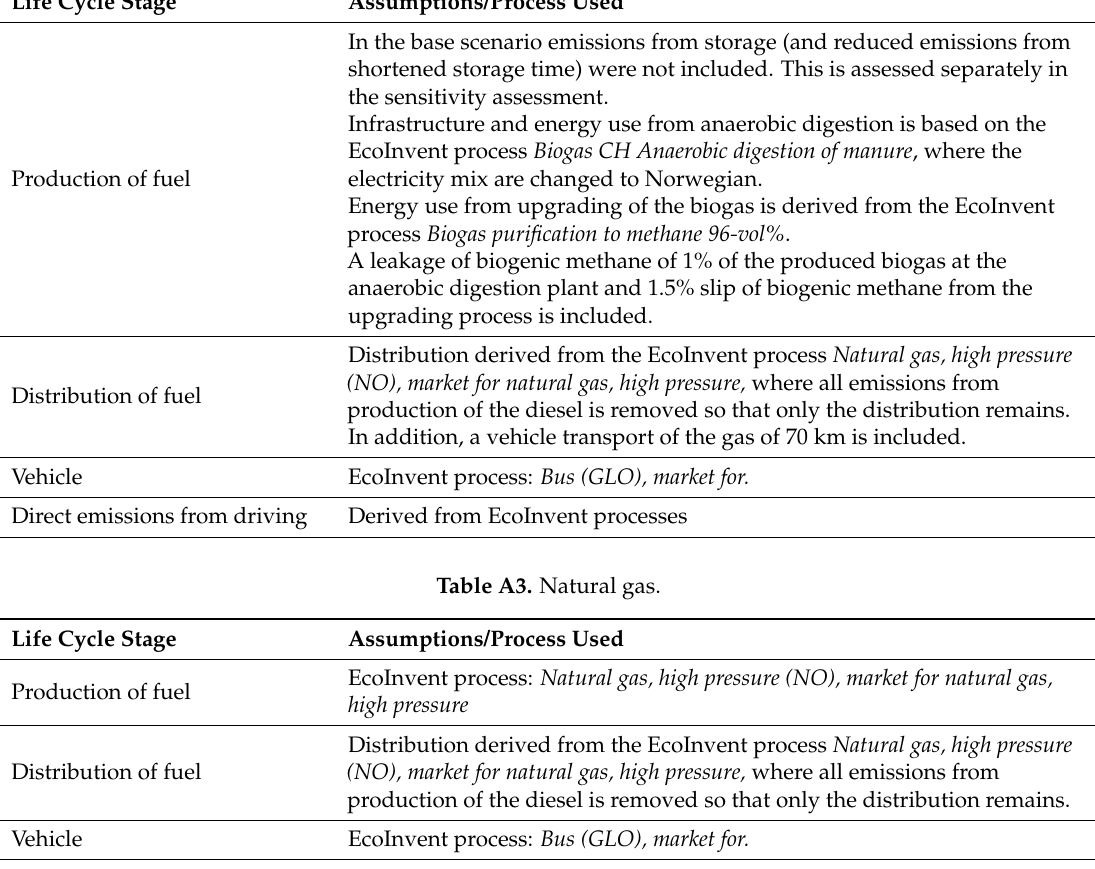
Table A2. Biogas from food livestock manure.